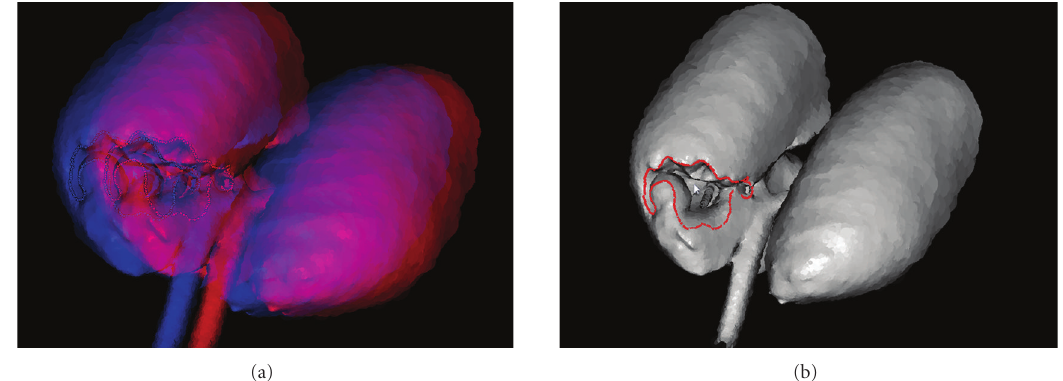
Figure 6: Marking the TB cavity boundaries on a 3D lung model using S3D toolset. Left: red-blue stereoscopic representation mode. Right: ordinary perspective representation.